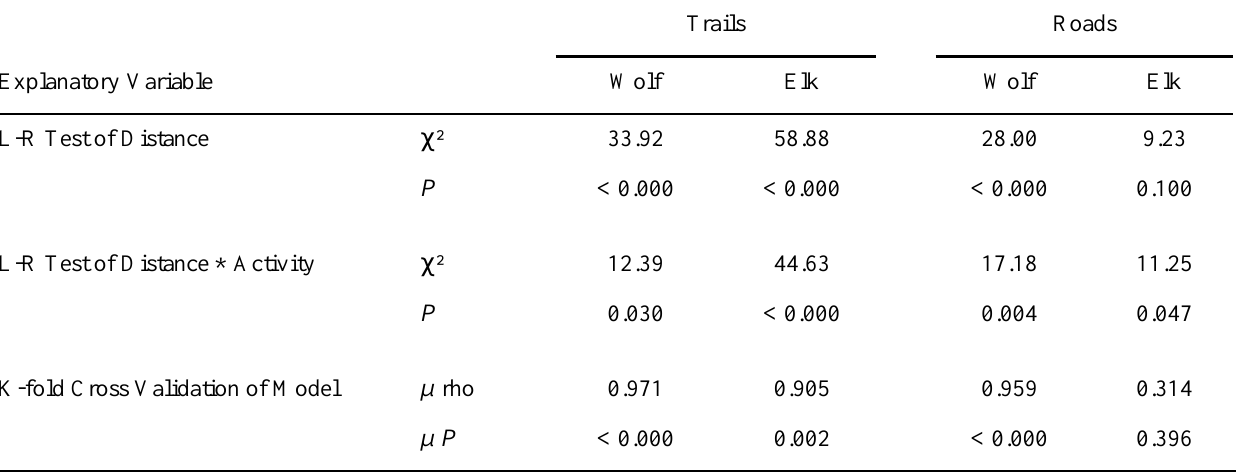
Table 1. Likelihood ratio test and P-value (significance at < 0.05) results of distance-to-trail/road categorical variable and distance-to-trail/road*hourly trail/road activity categorical interaction variable using nested models for each species. Mean Spearman’s rho and P-value of 5-fold cross validation tests performed on models with significant interaction